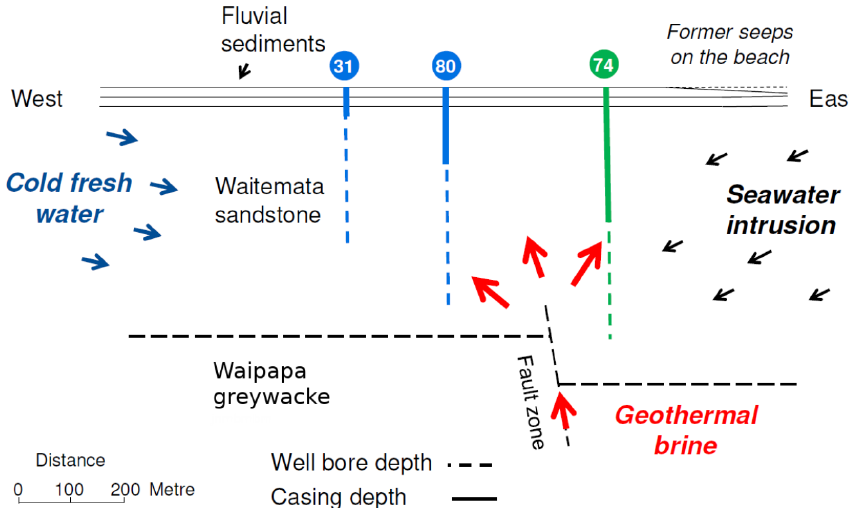
Figure 1. W–E cross section. The arrows depict the flow directions. The bore holes no. 31 and no. 80 are the major production wells (blue colour) and no. 74 is the observation well (green colour) close to the sea (modified after Kühn and Altmannsberger,